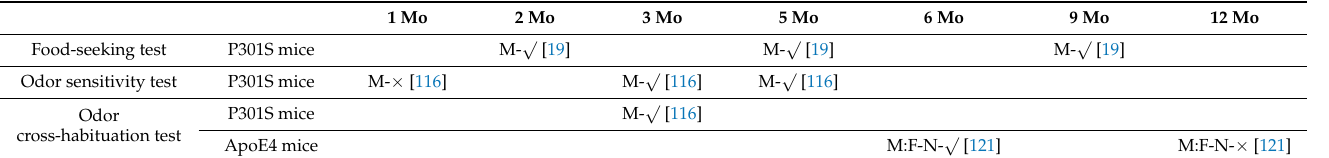
Table 6. Summary of data on the behavioral performance of the P301S and the ApoE4 mice. “M:F- N-X” represented “sex-sex ratio-whether there is a difference”. Mo: month, M: male, F: female, N: √ unclear, × : no significant difference, : significant